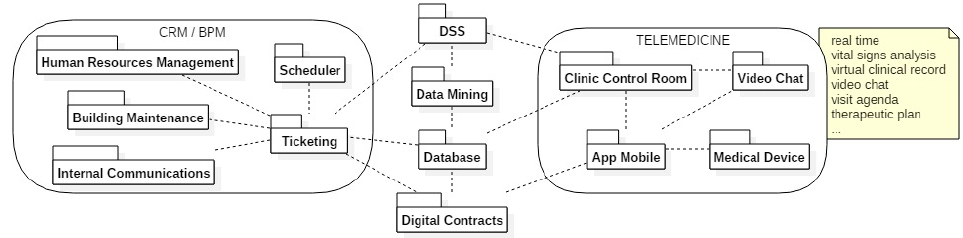
Figure 6. The features exposed by the RMP-DSS platform.